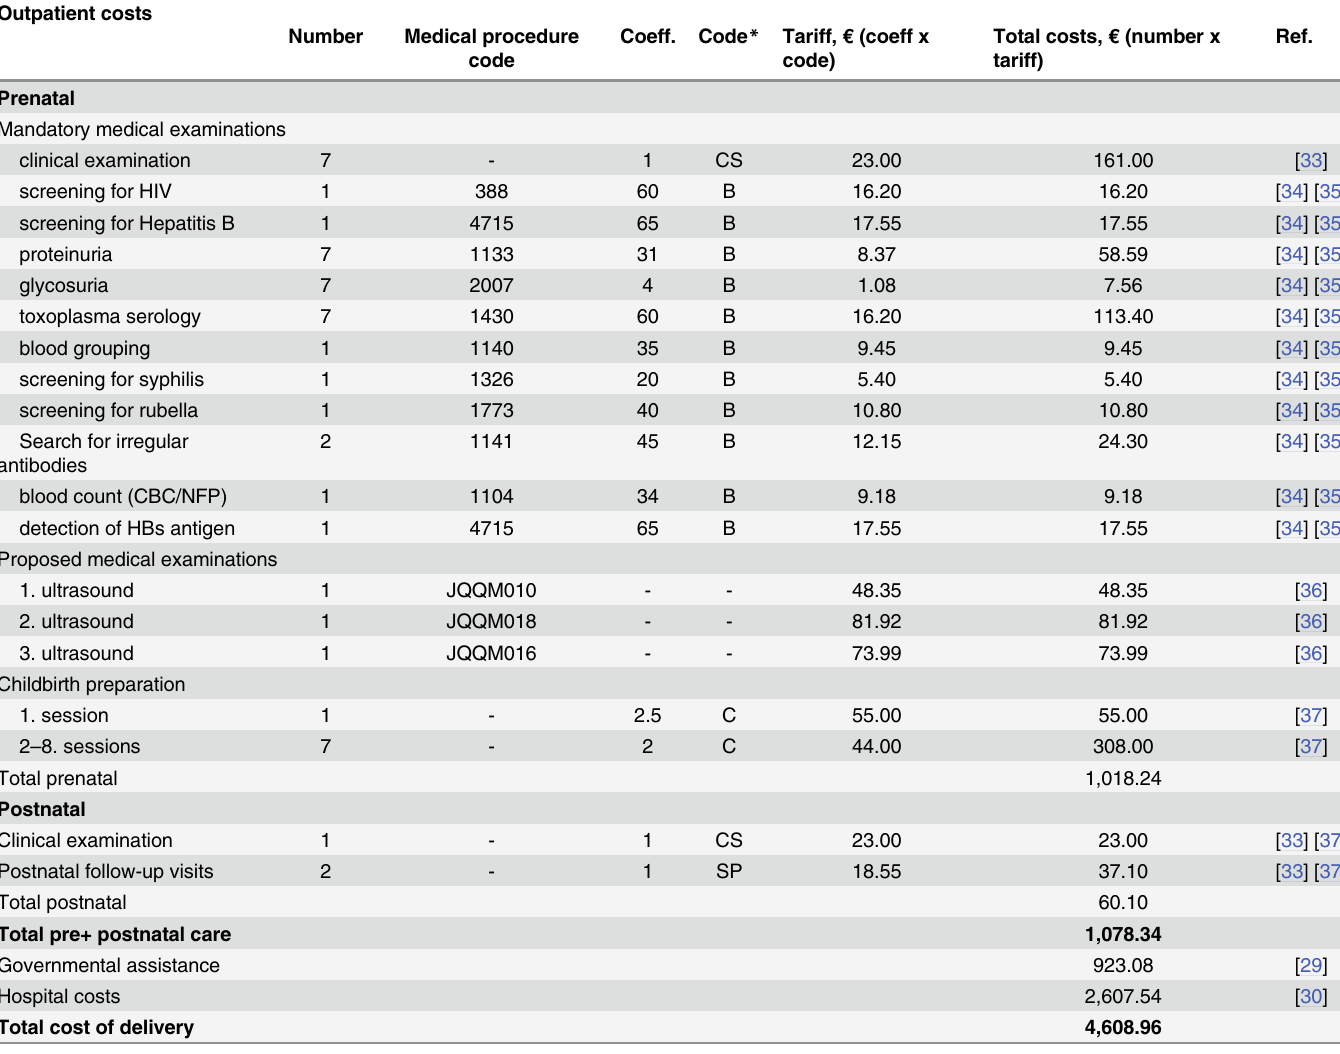
Table 2. Pre- and postnatal care utilization and